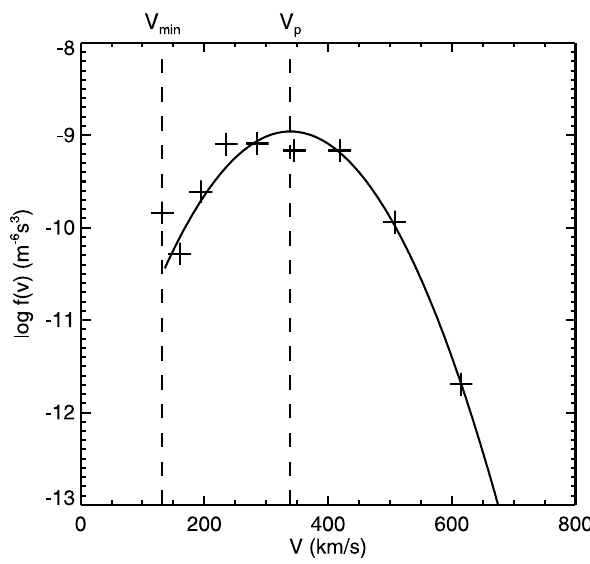
Fig. 14. The crosses represent the values of the ion distribution function [m − 6 s 3 ] where the differential energy flux is 90% or less of the peak measurement (the white crosses in Fig. 13). The particle energy has been converted to a proton velocity v (E= 1 solid line is a maxwellian fit to the data points. The peak of the fitted maxwellian v p is equal to 340kms − 1